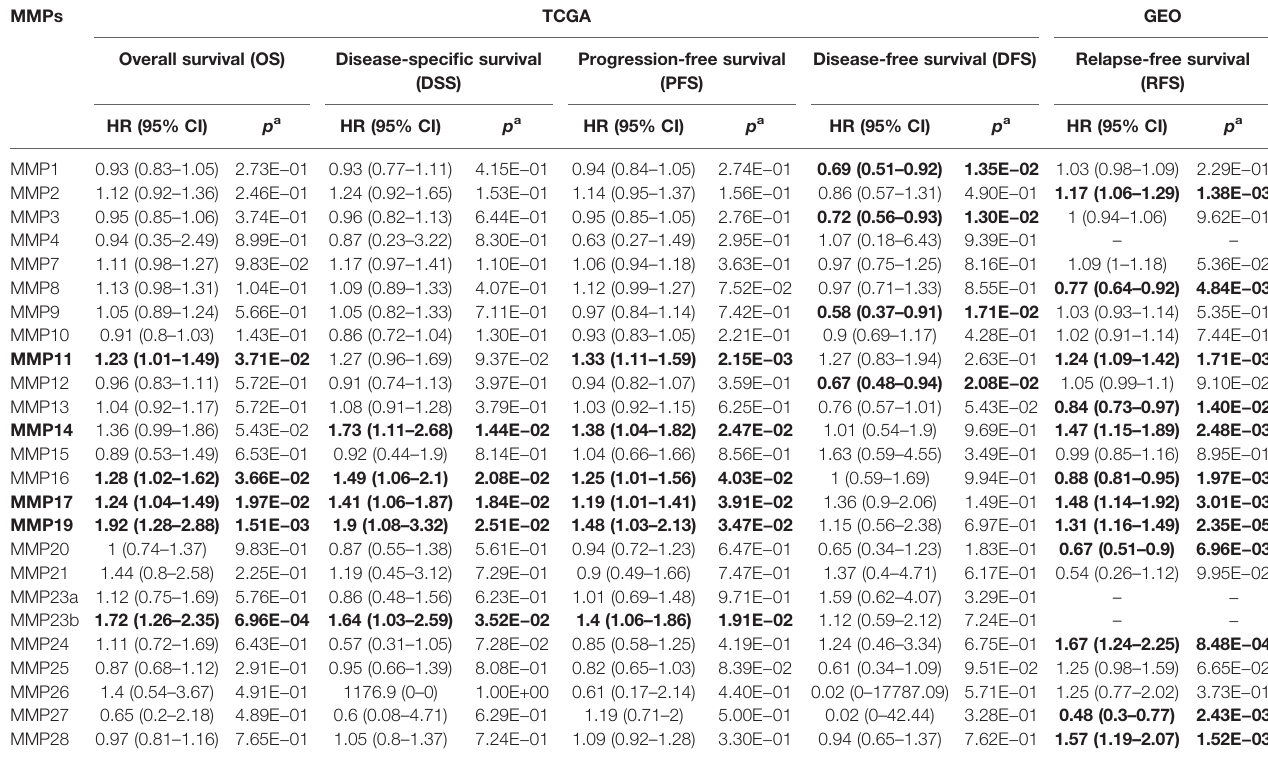
TABLE 1 | Association of the mRNA expression of MMPs with the prognosis of patients with colorectal